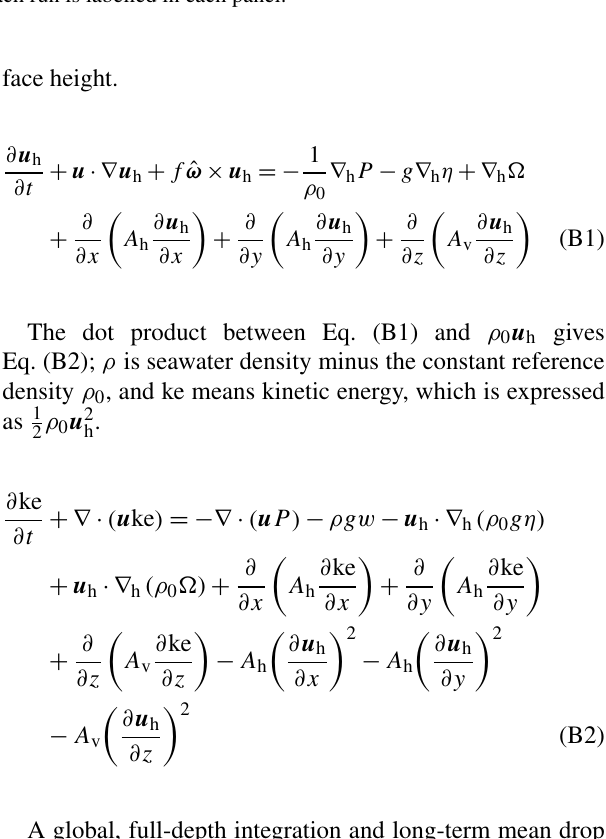
Figure A1. Co-tidal charts of M2 tides from the time step sensitivity runs. The colours indicate tide amplitudes, and the white lines indicate Greenwich phase lags with an interval of 60 ◦ . The time step setting in each run is labelled in each